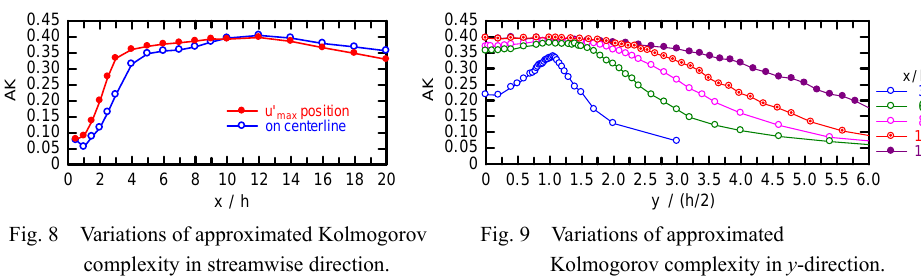
Fig. 8 Variations of approximated Kolmogorov Fig. 9 Variations of approximated complexity in streamwise direction. Kolmogorov complexity in y